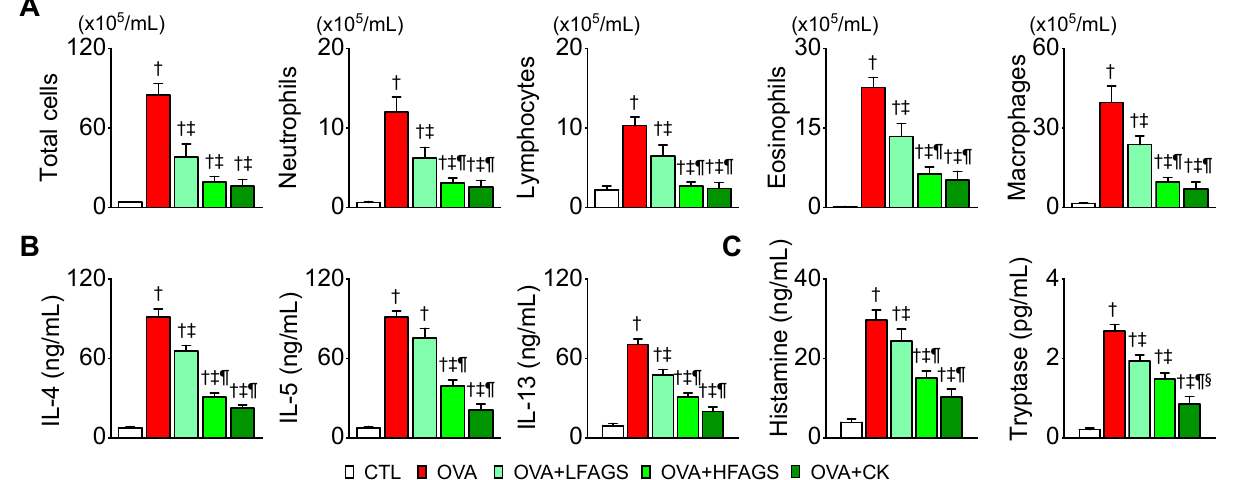
Figure 3. Inhibitory effects of FAGS and CK on OVA-induced increase in inflammatory cells, Th2 cytokines, histamine, and tryptase in BALF. ( A ) Total and differential inflammatory cell count in BALF. Differential cell counts were assessed using Diff-Quick staining. ( B) Measurement of Th2 cytokines (IL-4, IL-5, and IL-13) in BALF. ( C ) Measurement of histamine and tryptase secreted from mast cells. Data are shown as mean ± SE (CTL, n = 10; OVA, n = 10; OVA + LFAGS, n = 5; OVA + HFAGS, n = 10; OVA + CK, n = 5). † p < 0.05 compared with CTL. ‡ p < 0.05 compared with OVA. ¶ p < 0.05 compared with LFAGS. § p < 0.05 compared with